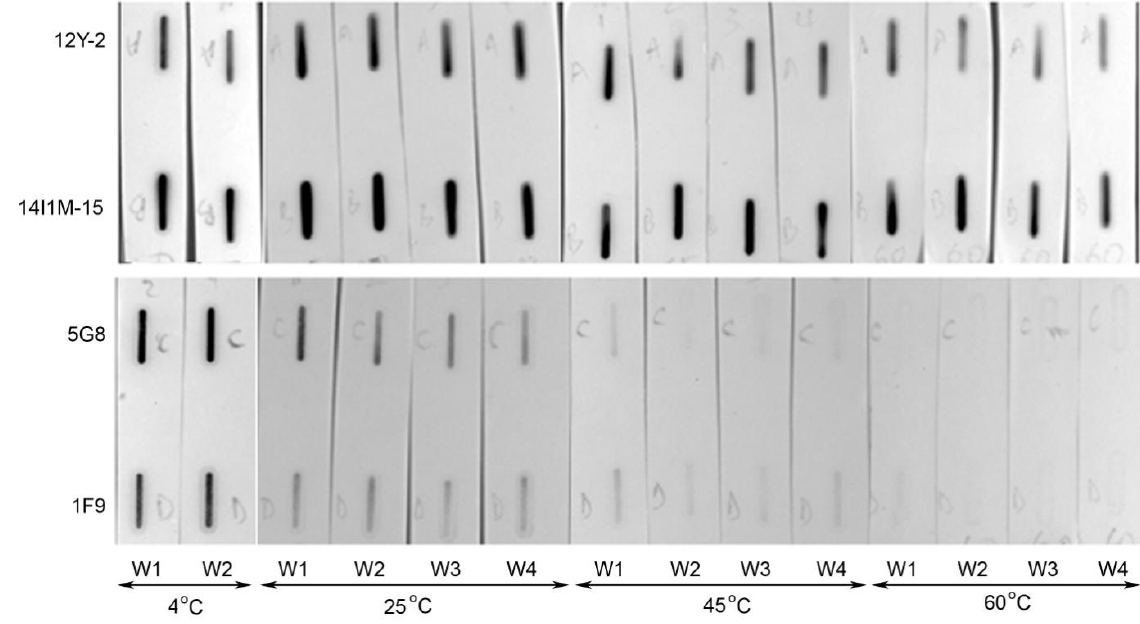
Figure 4. Retention of activity of V s and monoclonal antibodies immobilized on NAR nitrocellulose, following heating at various temperatures and time periods (W =